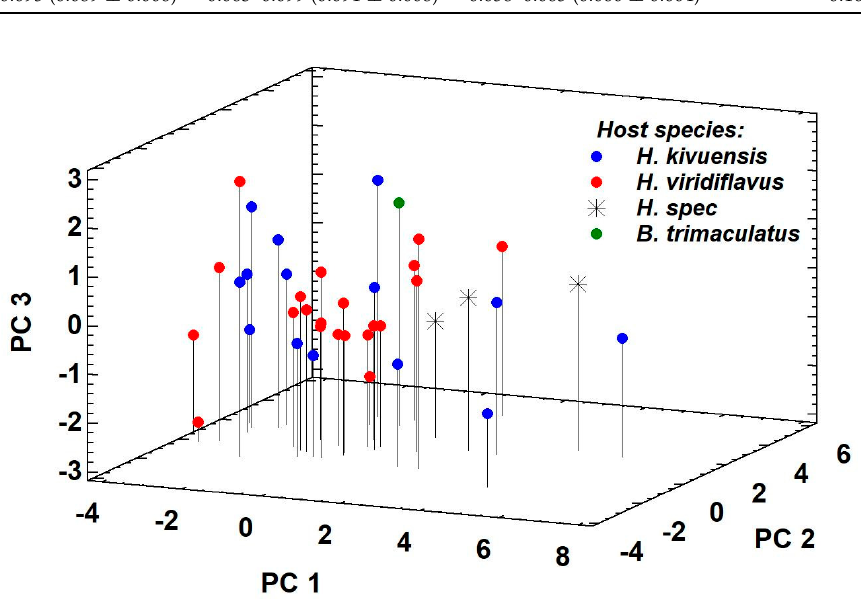
Figure 1. Ventral view on metacercariae of Clinostomum chabaudi. (A) Modified schematic drawing from Vercammen-Grandjean (1960) [11]. (B) Photograph of a fully grown, live metacercaria infest- ing the dorsal lymphatic sac of a H. viridiflavus male in March 2017. Scale bar = 1 mm. Genital com- plex, abbreviations: AT = anterior testis, CP = cirrus pouch, OV = ovary, PT = posterior testis.